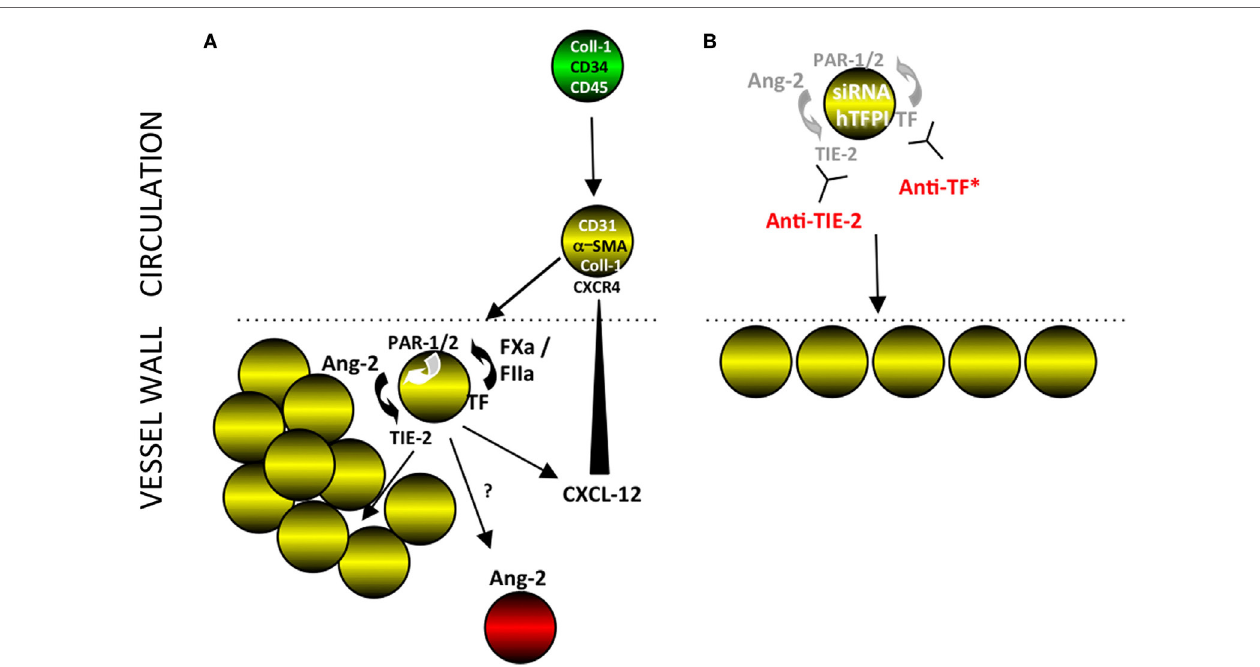
FigUre 14 | Interpretation of our findings. (a) Post-endoluminal injury, fibrocytes (green) are mobilized into the circulation, a subpopulation of which express smooth muscle actin (SMA) (“myofibrocytes”-yellow cells) and CD31 and these are recruited to the site of injury, via CXCR4 from CXCL-12 released from luminal platelets (data not shown). These myofibrocytes express tissue factor (TF), which generates FXa and thrombin (FIIa), which can signal through PARs-1 and -2 on the cell surface. These result in the secretion of angiopoietin-2, which through cell surface TIE-2, causes proliferation and secretion of CXCL-12, which can attract more myofibrocytes from the circulation. The myofibrocytes also orchestrate expression of angiopoietin-2 by other cells within the vessel wall, by a mechanism not elucidated. (B) Inhibition of TF on the myofibrocytes, either by cell surface expression of a transgenic human tissue factor pathway inhibitor (hTFPI) fusion protein, or by an anti-TF antibody inhibits angiopoietin-2 secretion and results in a small neointima, consisting of non-proliferating myofibrocytes. An siRNA to angiopoietin-2 or a blocking anti-TIE-2 antibody has the same effect, illustrating the key importance of the angiopoietin-2/TIE axis for the development of intimal hyperplasia. *Treatment of whole CD34 + cells with an anti-TF inhibits intimal hyperplasia (IH) but also prevents significant recruitment of myofibrocytes, in a similar way as expressing hTFPI fusion protein on SMA + fibrocytes